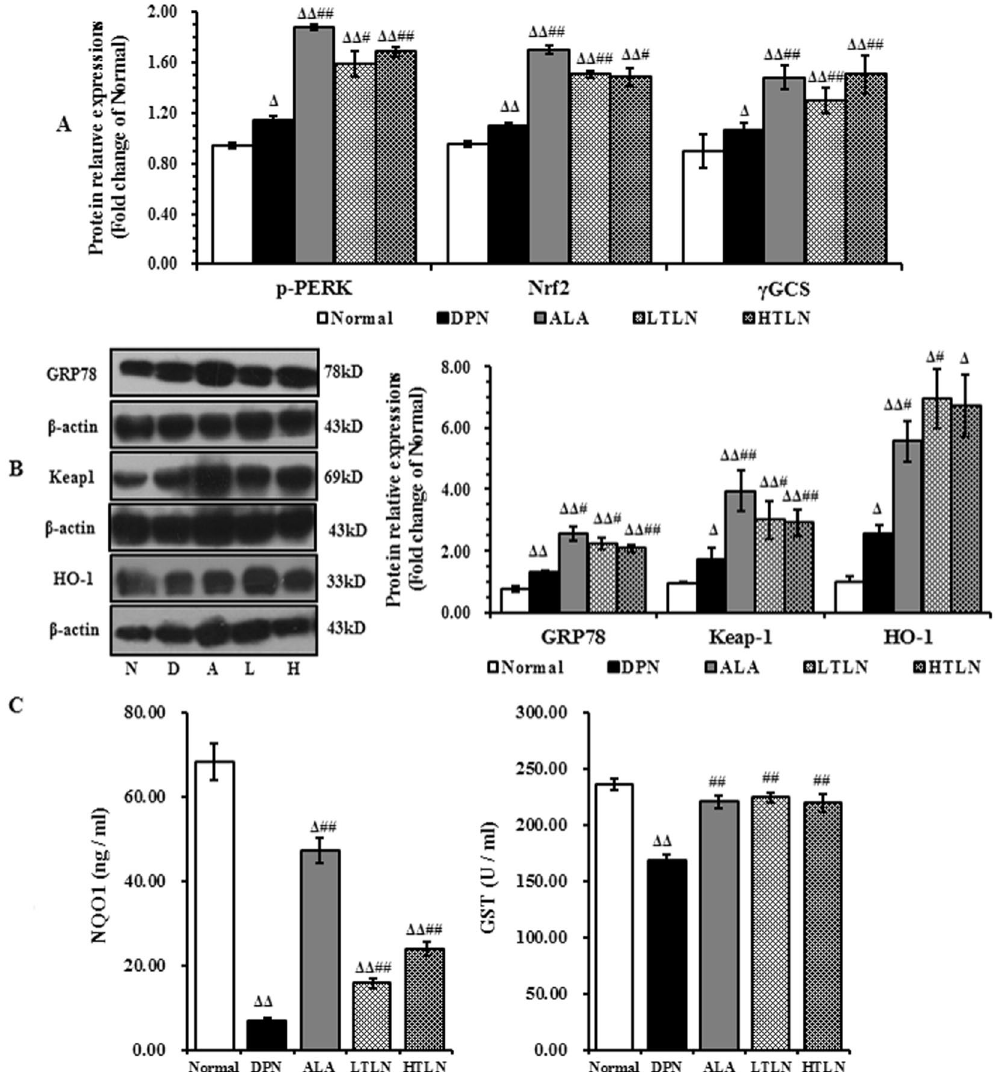
Figure 1. Up-regulation of the PERK/Nrf2 pathway in sciatic nerve of STZ-induced DPN rats by TLN. ( A ) The relative expression of p-PERK, Nrf2 and γ GCS determined by double-immunostaining 12 weeks after TLN treatment. ( B ) Representative Western blot of GRP78, Keap1 and HO-1 12 weeks after TLN treatment (Left panel), and the relative fold changes of GRP78, Keap1 and HO-1. ( C ) The serum levels of NQO1 and GST 12 weeks after TLN treatment. NQO1 was detected using the ELISA kit. GST activity was determined using a colorimetric method. Data are shown as mean ± S.E.M. Δ P < 0.05, ΔΔ P < 0.01 vs. Normal group; # P < 0.05, ## P < 0.01 vs. DPN group. Data were analyzed by One-way ANOVA followed by least significant difference or Tambane’s T2 analysis (n = 6 animals per